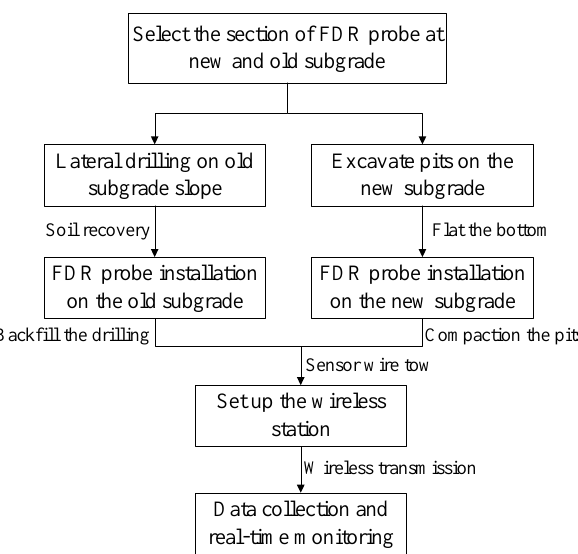
Figure 2. Flow diagram of FDR sensor installation. Sensors 2016 , 16 , 857